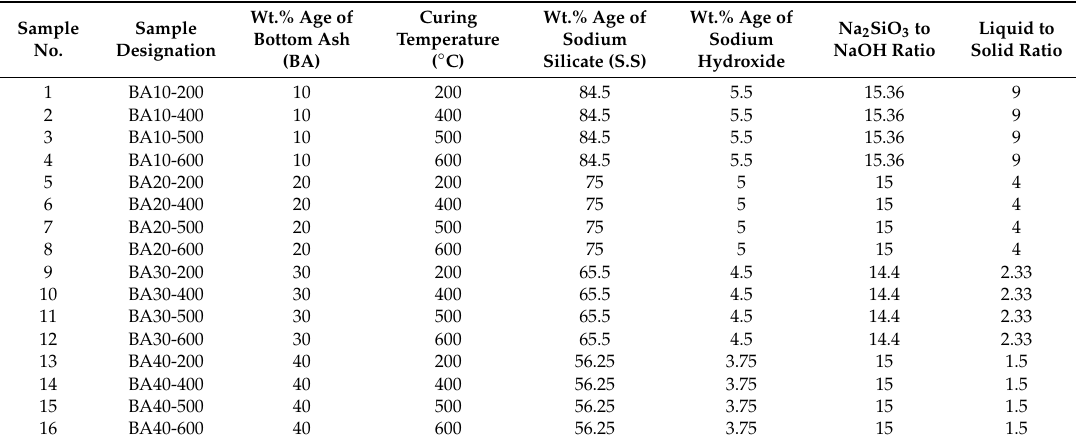
Table 1. Sample designations and